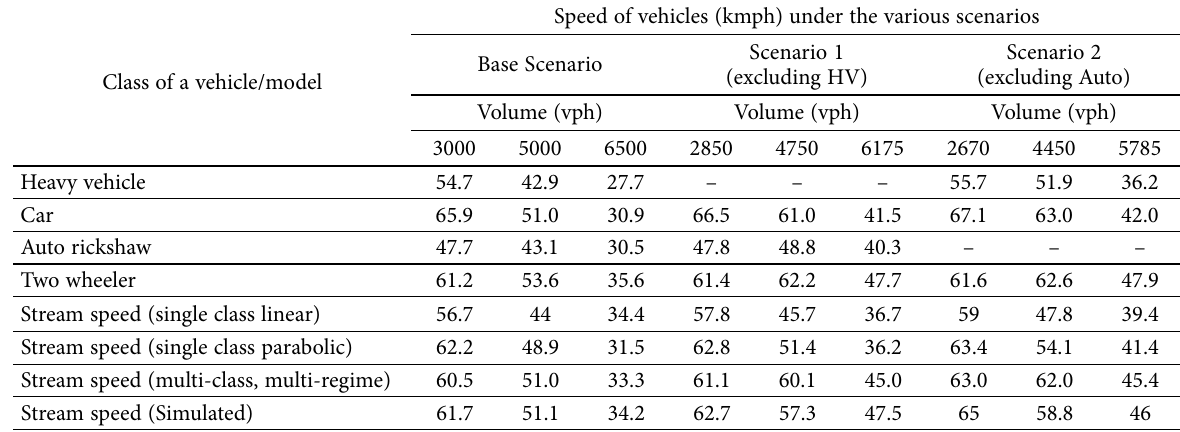
Table 5. A comparison of speeds in different traffic